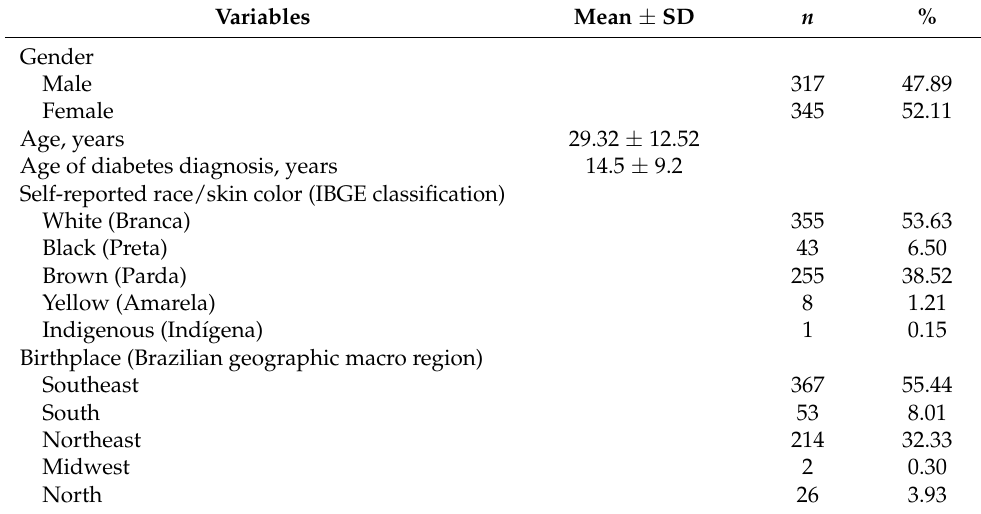
Table 1. Descriptive analysis of the study sample of Brazilian patients with type 1 diabetes ( n = 662).